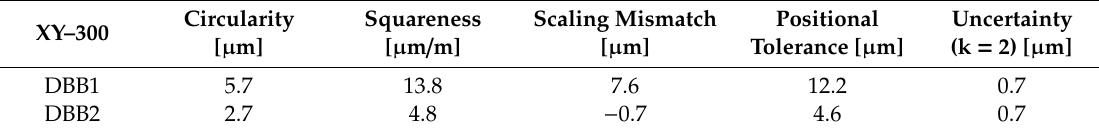
Table 10. Results of the circularity test—100 mm diameter.